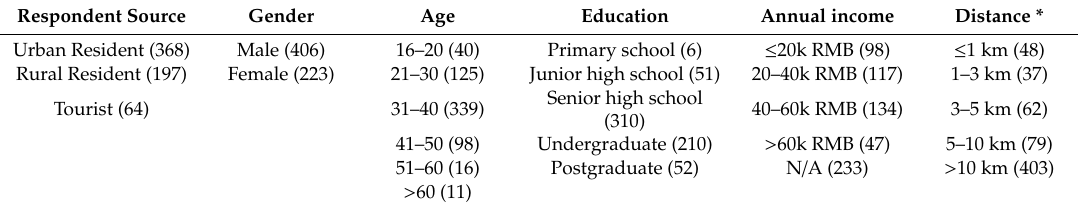
Table 2. The demographic information of respondents.